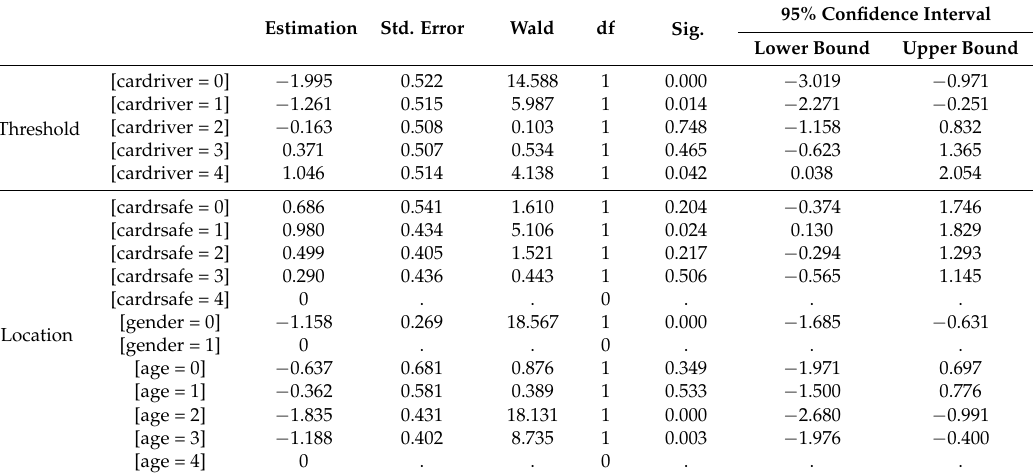
Table A2. Parameter Estimates for the private car model. Estimation Std. Error